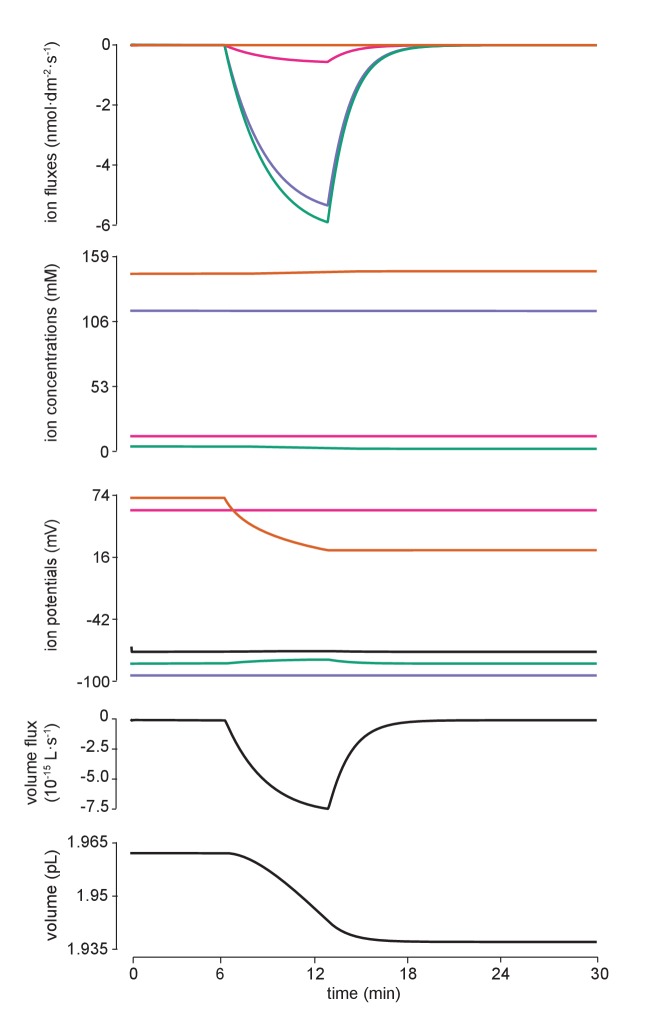
Flux of all ions for the manipulation in Figure 4c.Detailed fluxes of all ions and changes to volume during addition of impermeant anions of average charge. The flux of ions across the membrane for potassium (purple, K+), sodium (pink, Na+), chloride (green, Cl-) and impermeant anions (orange, (X) are shown in the top panel. Concentration and reversal potential changes are depicted in the second and third panels from the top. Whilst there is a large inward (intracellular) flux of impermeant anions as dictated by the experiment, this is not solely mitigated by fluxes of chloride, the other intracellular anion, but also by potassium and sodium fluxes as well as the movement of water (ie volume changes). The rate of change in volume (representing water movement) is shown in the fourth panel from the top while the bottom panel depicts volume itself.